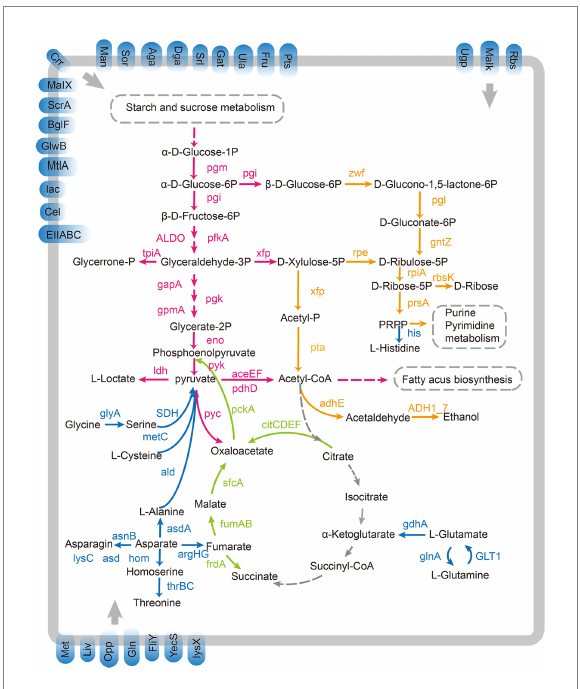
FIGURE 4 Overview of proposed pathways present in L. paracasei SMN- LBK. Pink arrows represent the homolactic fermentation pathway. Orange arrows represent the heterolactic fermentation pathways. Green arrows represent the incomplete citrate metabolism pathways. Blue arrows represent the proteolysis and amino acid metabolism pathways. Blue squares embedded in the membrane represent PTSs and ABC transporters. Gray dashed arrows represent the absence of this pathway. Gray dashed boxes represent other metabolic